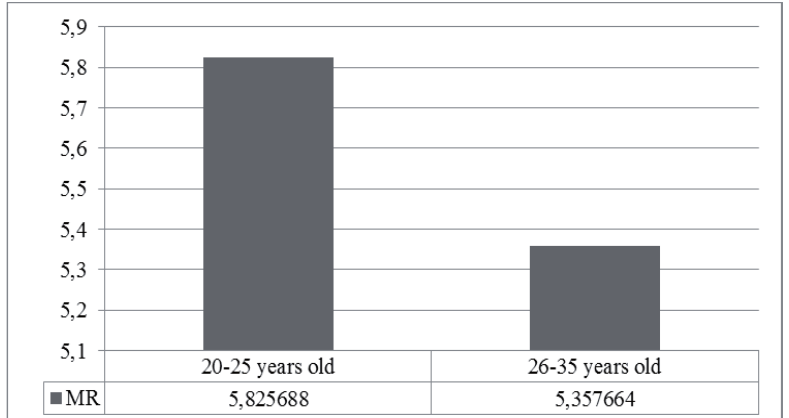
Figure 2. Statistically signi  cant difference of monetary mindset in people of different age MR – «Money as a means of attracting respect to a person» Application of unifactor dispersion analysis (variations analysis and Scheffe’s test) allowed to reveal differences in indicators on the scales «Obsession with money» and «Inadequate handling of money» in people with different educa- tion levels. The group of respondents with vocational specialized education have shown higher level of obsession with money (F = 5.848, p = 0.003, M = 5.9730) than people with complete higher education (F = 5.848, p = 0.003, M = 5.0833). They also have higher level of monetary mindset which testi  es to inadequate